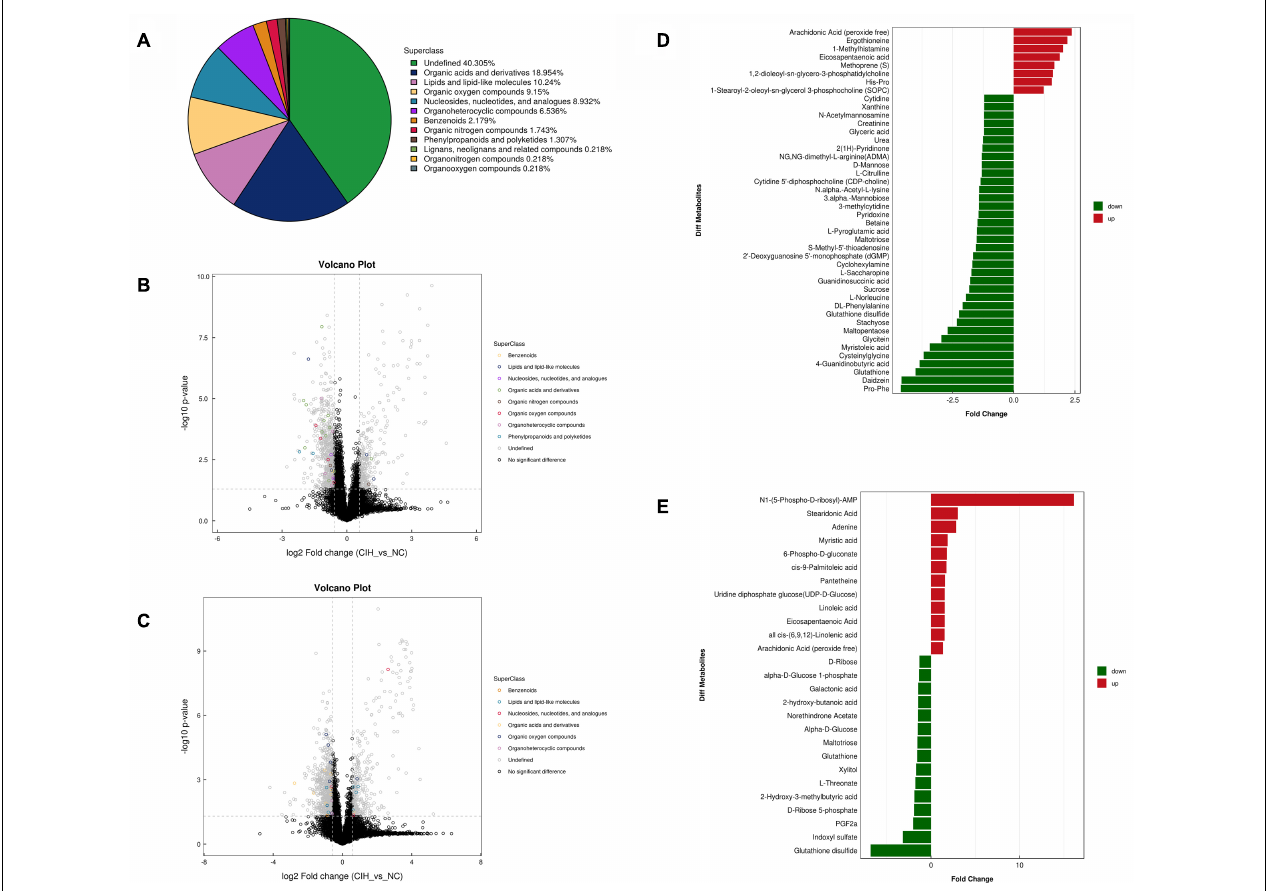
FIGURE 3 | Univariate analysis of UHPLC-Q-TOF/MS data (A) Superclass pie chart of differential metabolites between NC and CIH group. (B) Volcano plot in positive ion mode and (C) negative ion mode. Each point in the volcano plot represents a metabolite. Differentially abundant metabolites of different categories are individually color coded. (D) Histogram of significantly differentially detected metabolites in positive ion mode and (E) negative ion mode. The x -axis shows the fold change; the y -axis corresponds to the differential metabolites. Green and red indicate decreased and increased differential metabolites, respectively.